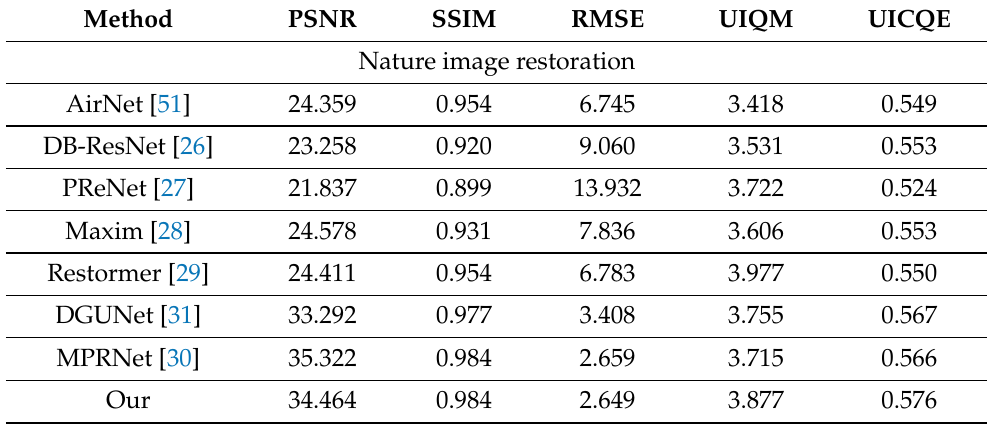
Table 1. Comparison results of UIR-Net with other SOTA methods on the MSRB